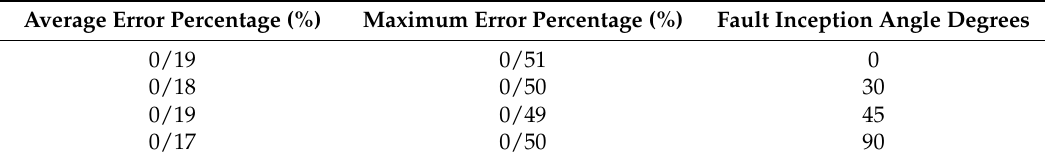
Table 4. Effect of fault inception angle on the proposed method.